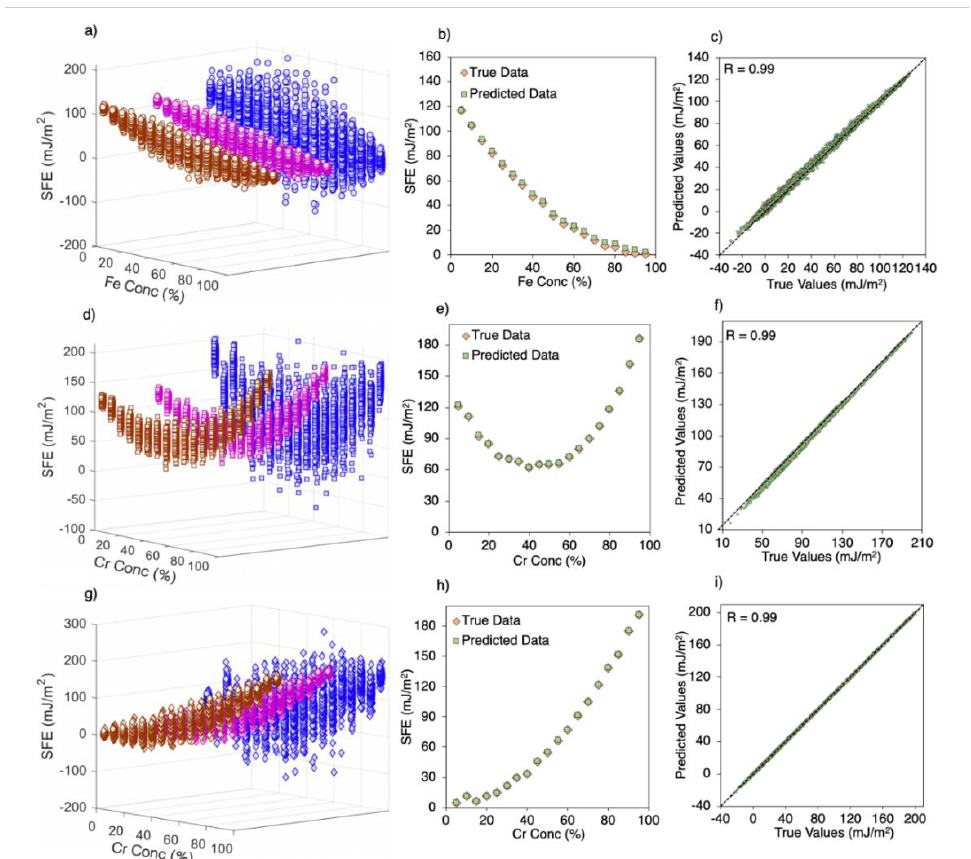
Figure 8. ( a – c ) Ni-Fe, ( d – f ) Ni-Cr, and ( g – i ) Fe-Cr. ( a , d , g ) SFE comparison among true data for 480-atom (blue circles), true data for 4320-atom (pink circles), and ML-predicted data for 4320-atom supercells (brown circles).The SFE variation from ML prediction, which is trained on 480-atom supercells, is almost of the same range as that of the true data of 4320-atom supercells, indicating the ability of ML to learn and predict SFE with high accuracy. ( b , e , h ) Average SFE comparison between true and predicted data for 4320-atom supercells. ( c , f , i ) Pearson plot between true and predicted value for 4320-atom supercells. Pearson coe ffi cient of 0.99 indicates excellent match between true and predicted values.